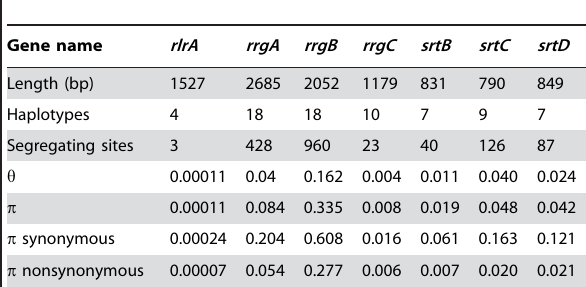
Table 1. Population genetics